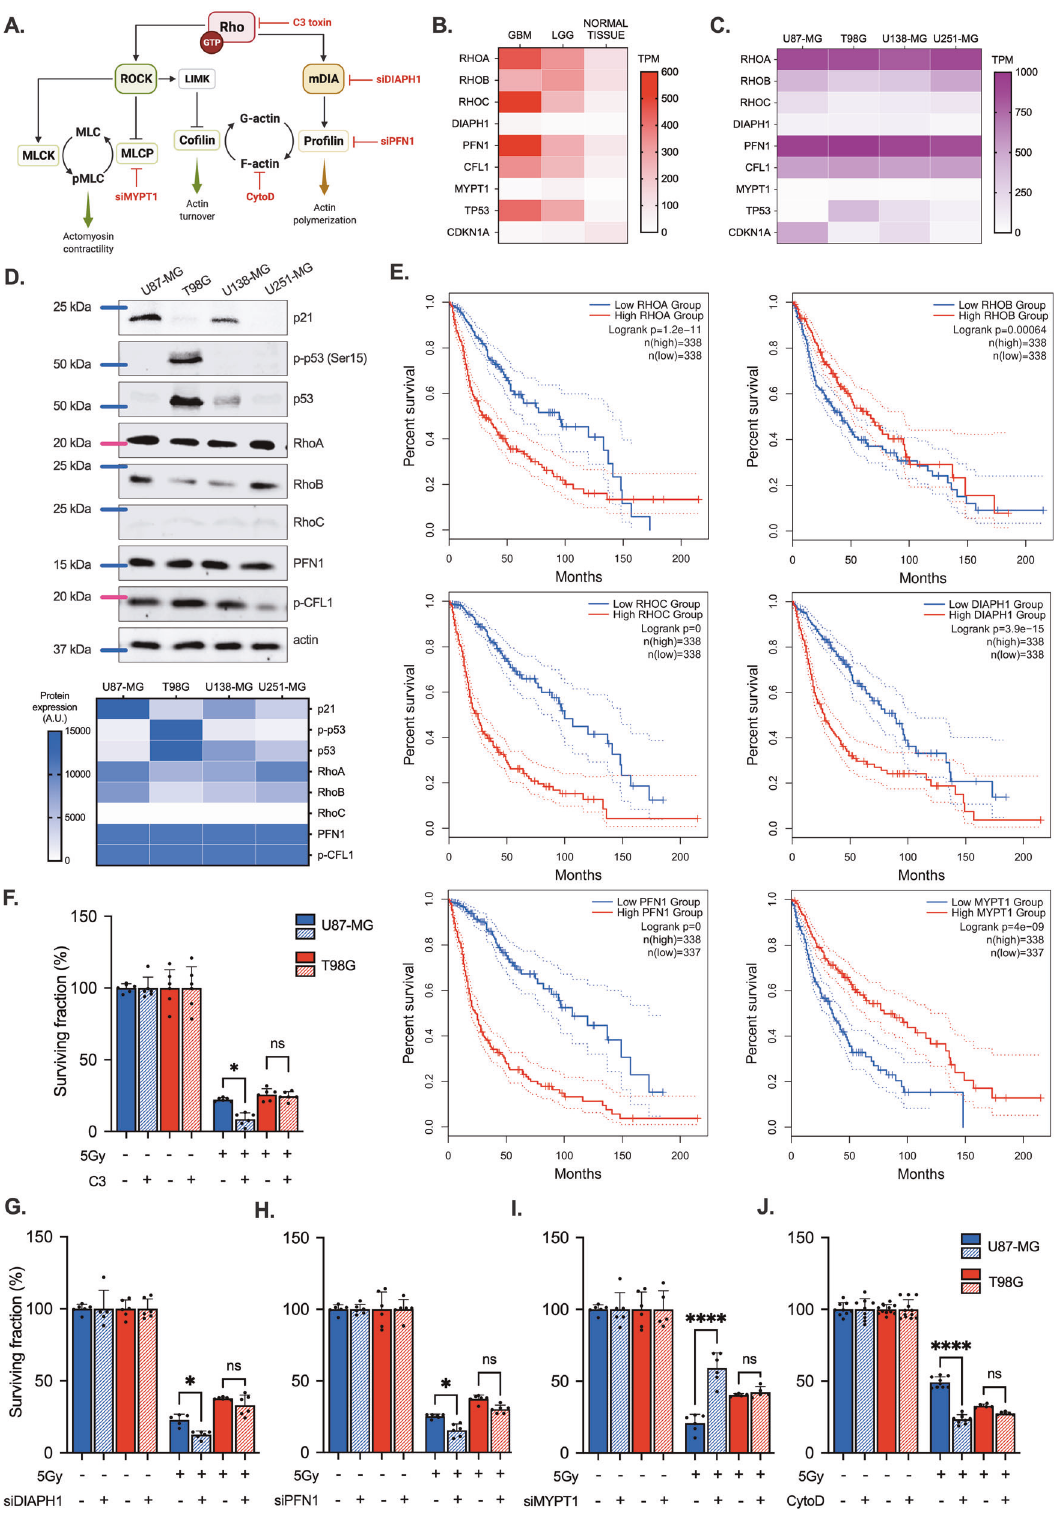
Statistical analysis All experiments were performed with at least three independent biological replicates of two to six technical replicates each. The exact numbers of biological replicates ( N ) are noted in the fi gure legends, and each replicate is shown in each graph as an individual dot. Outliers were identi fi ed using the